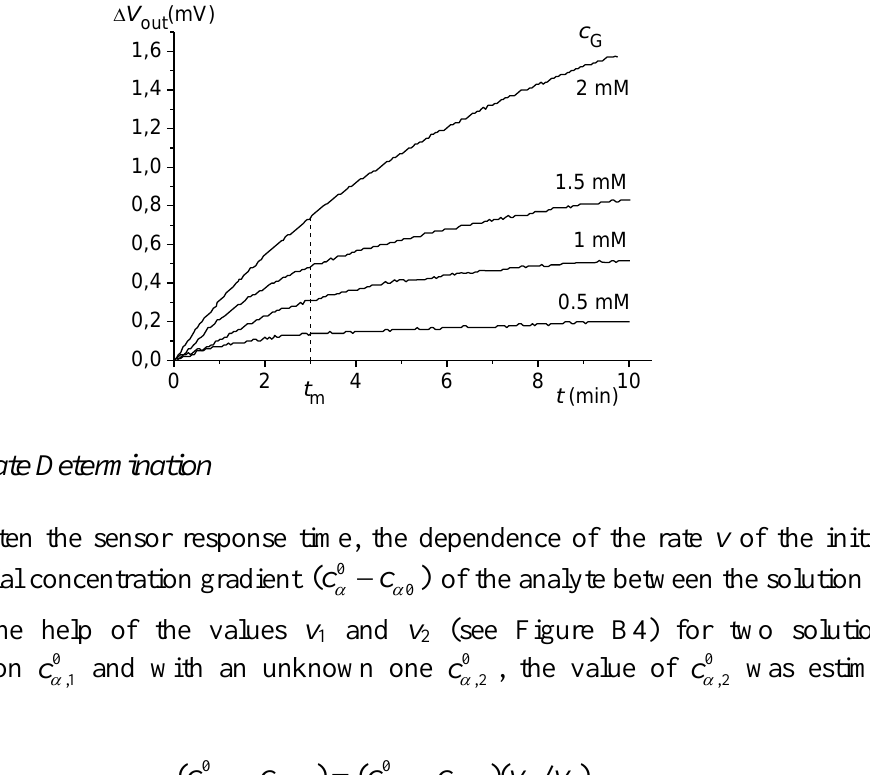
Figure B3. Time-dependent sensor response for different glucose concentration c PBS solutions (pH7.4, ionic strength 0.15 M) initially starting from c